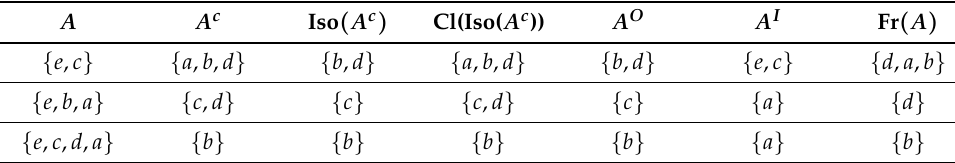
Table 4. Selected Knowledge States in Example